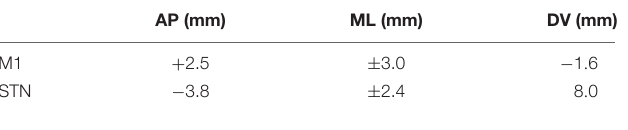
TABLE 2 | Electrode implantation coordinates in M1 and